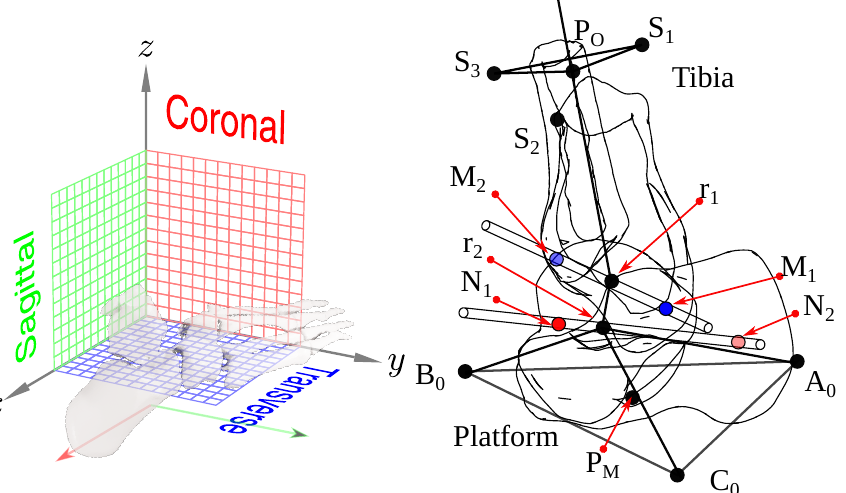
Figure 4. Planes, axes, and points of corresponding